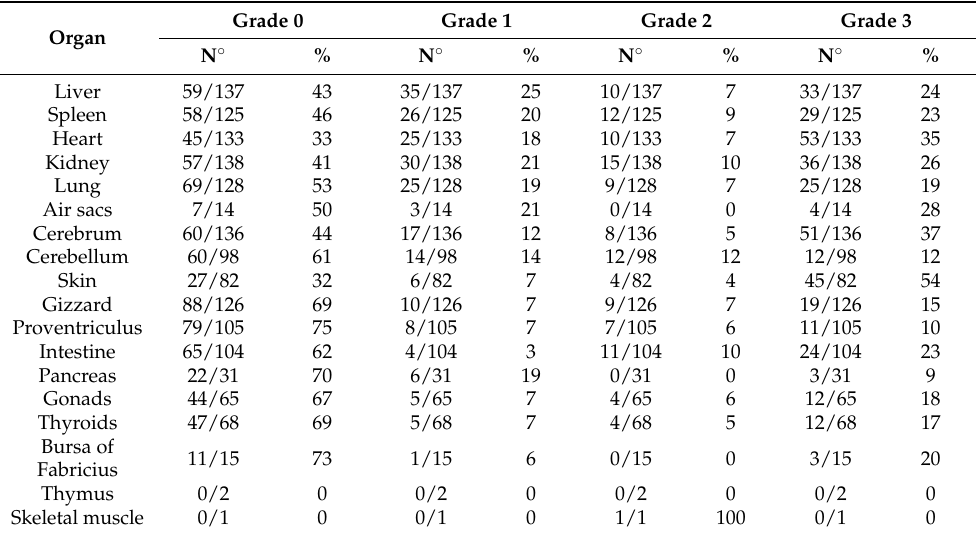
Table 5. Distribution of IHC grades in the available tissues of the most commonly affected organs (all percentages rounded off to the bottom) of blackbirds infected with